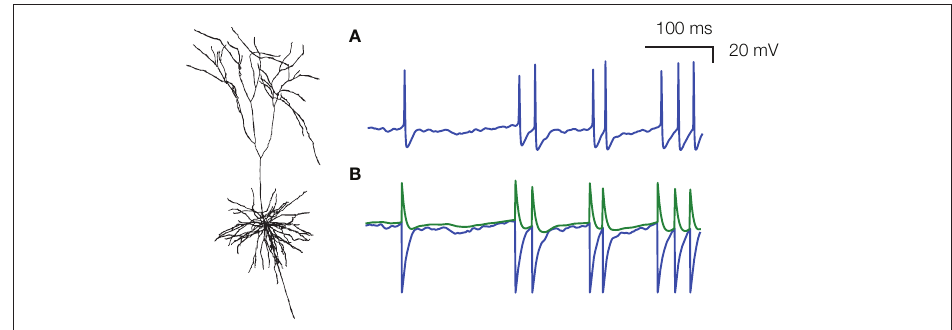
Figure 5 | reduction of a complex biophysical model to a phenomenological spiking model. The response of a multicompartmental cortical neuron model (Hu et al., 2009) to a fluctuating current is simulated (A) , and fitted by an integrate-and-fire model with adaptive threshold (B) , as defined in (Rossant et al., 2010). The threshold is in green and the membrane potential in blue (note that the voltage unit for the model is arbitrary). The simpler spiking model could predict about 90% of spikes with a 4-ms precision ( Γ =